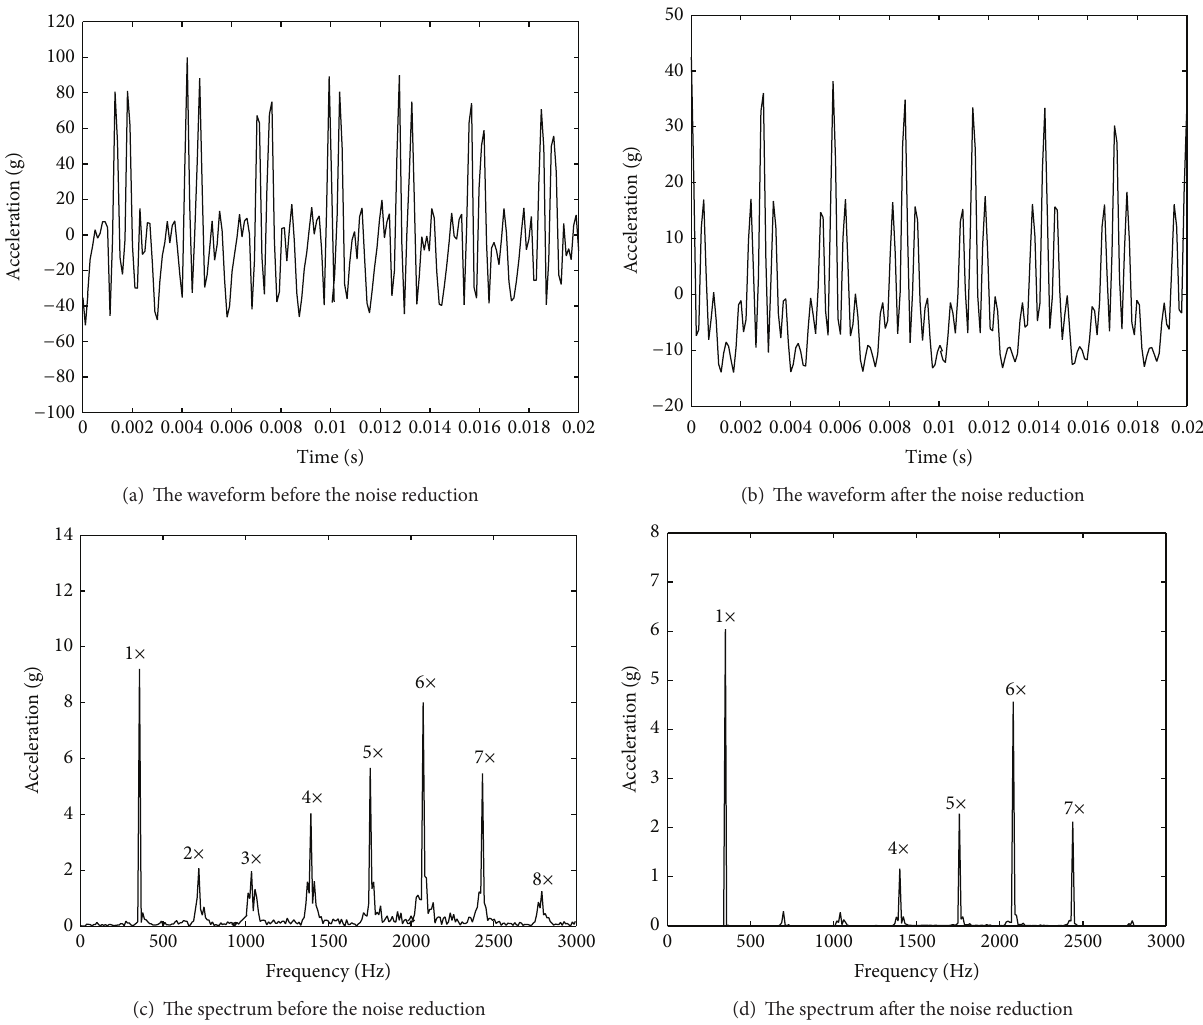
Figure 17: The time domain waveform and frequency spectrum before and after the noise reduction when rotating speed is 21000rpm.